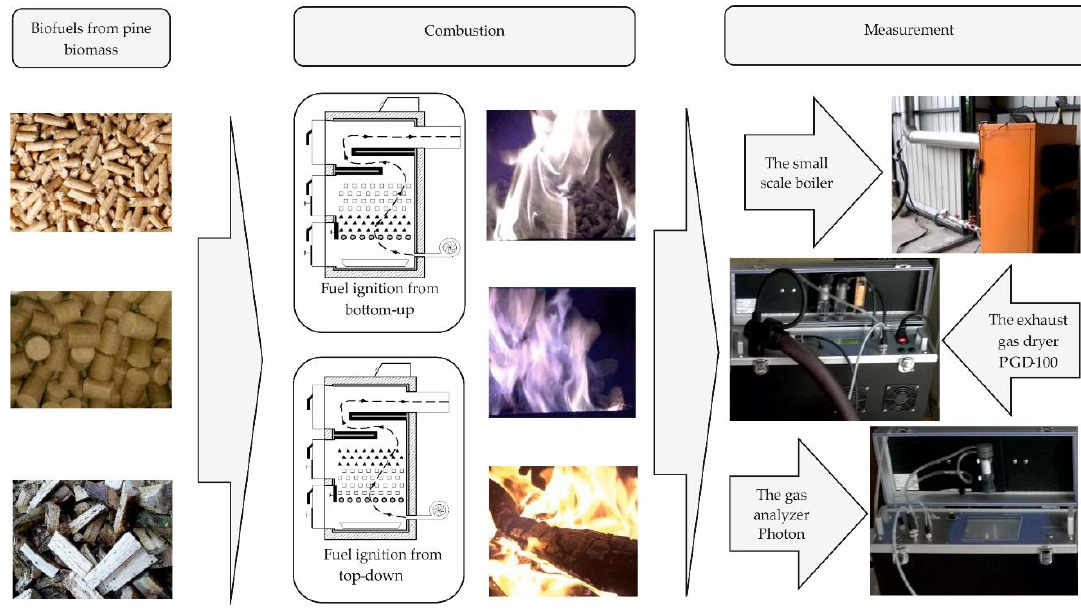
Figure 1. Scheme of stages of conducting an experiment (triangles mark the ignition initiation layer and squares indicate fuel).